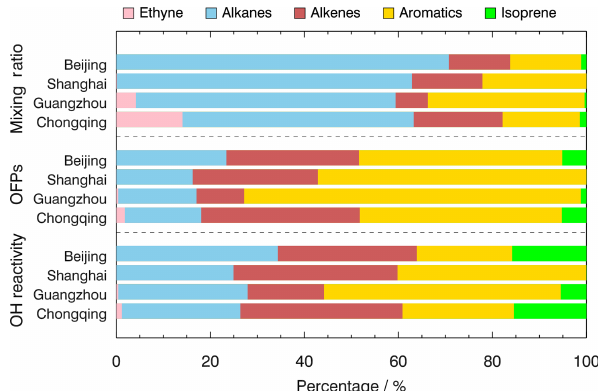
Figure 6. Group compositions (mixing ratios) in percentage for pri- mary VOCs and their shares in the OFPs and OH reactivity for four